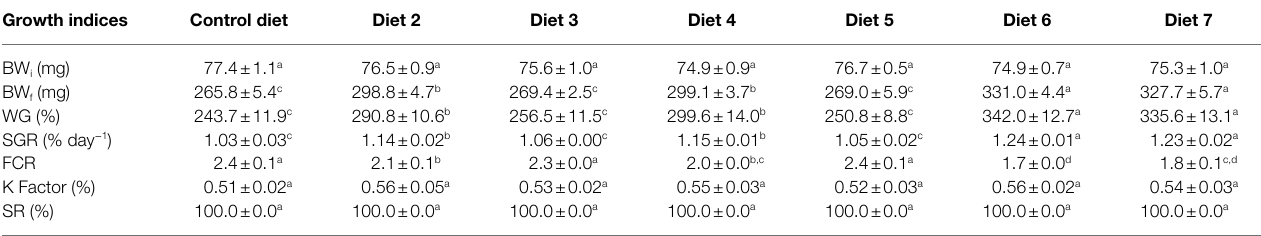
TABLE 3 | Growth performance and survival of zebrafish fed different experimental diets for 120